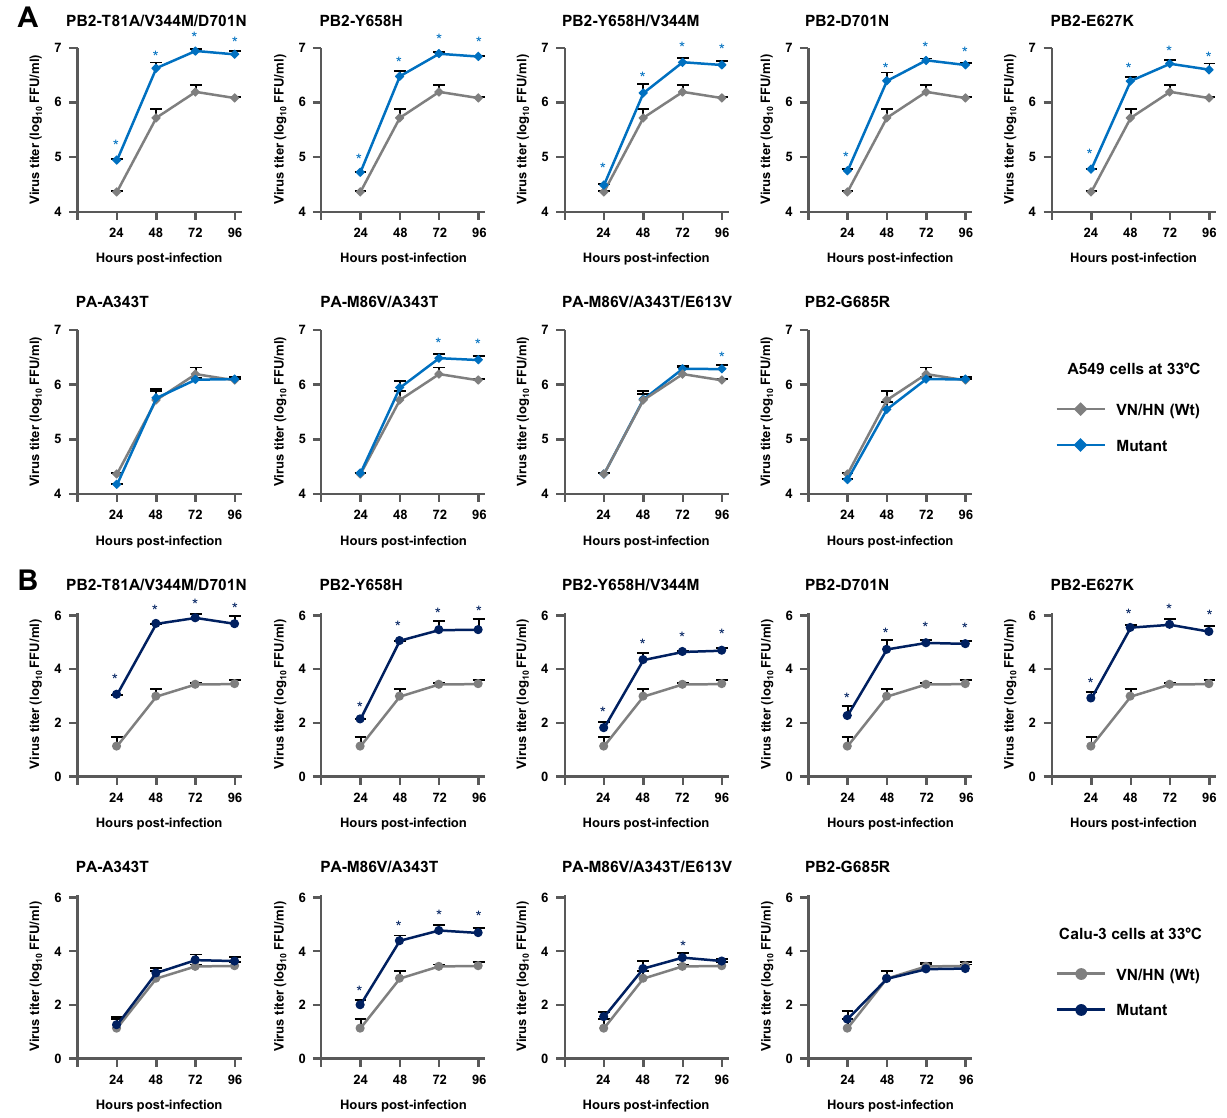
Figure 3. Effect of H5N1 polymerase mutations on viral growth in human airway epithelial cells at 33 °C. ( A ) A549 cells and ( B ) Calu-3 cells were infected with the indicated VN/HN viruses at an MOI of 0.03 and incubated at 33 °C. The culture supernatants were harvested at the indicated times and assayed for focus- forming units to determine the progeny virus titers. Each data point is the mean ± SD of the log 10 FFU/ml from three separate experiments. An asterisk indicates a P value < 0.01 (ANOVA with Tukey’s multiple comparison